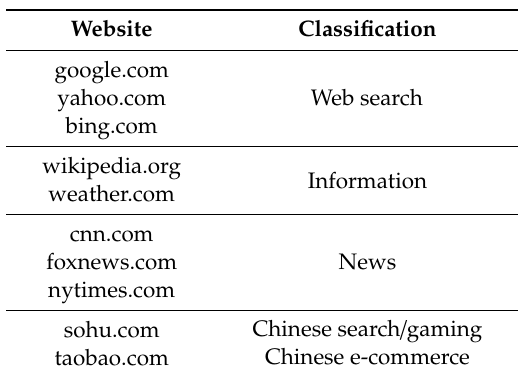
Table 1. Analyzed websites and their